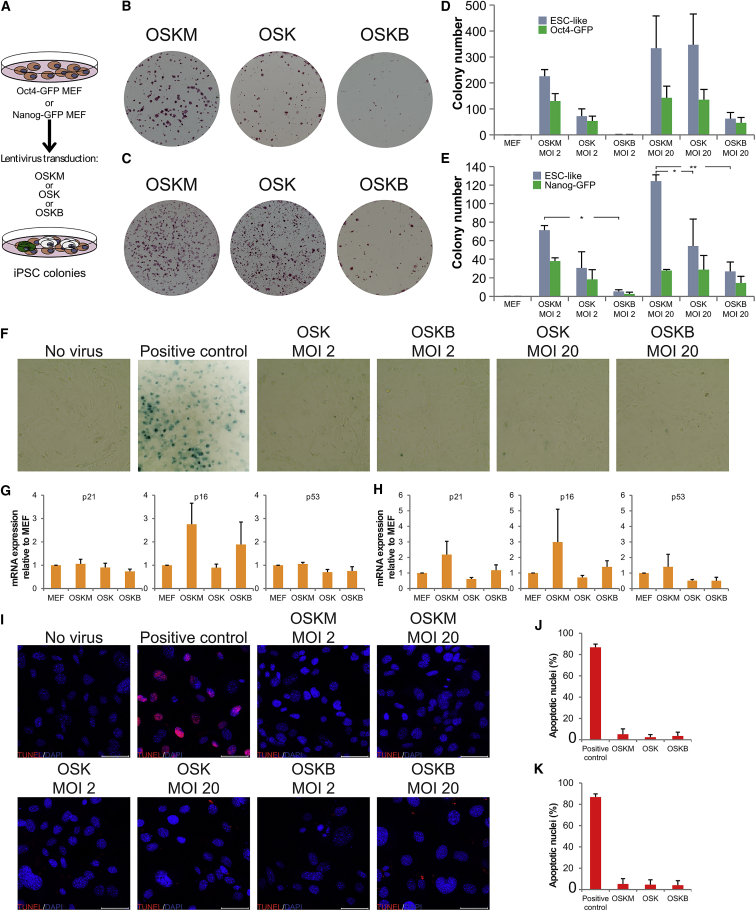
Mybl2 Overexpression Inhibits Somatic Reprogramming(A) Schematic representation of the experimental procedure. Oct4-GFP or Nanog-GFP MEFs were transduced with MOI 2 or MOI 20 OSKM, OSK, or OSKB lentiviral particles and allowed to reprogram for 14 days before GFP+ colonies were counted. The cells were stained for alkaline phosphatase activity.(B and C) Alkaline phosphatase staining (red) of Oct4-GFP MEFs at day 14 after transduction with MOI 2 (B) or MOI 20 (C).(D) Bar graph representing the number of ESC-like colonies based on morphology and the number of Oct4-GFP-expressing colonies. Error bars represent SEMs. n = 3 biological replicates.(E) Bar graph representing the number of ESC-like colonies based on morphology and the number of Nanog-GFP-expressing colonies. Error bars represent SEMs. n = 3 biological replicates. ∗p < 0.05, ∗∗p < 0.01.(F) Oct4-GFP MEFs were transduced with OSKB or OSK lentiviral particles at MOI 2 or MOI 20. After 3 days the cells were fixed and stained for β-galactosidase activity, a marker of senescent cells. Representative image from 20× magnification inverted bright-field microscope. For positive control, MEFs were cultured at 100% confluence for 10 days without passage. n = 2 biological replicates.(G and H) Wild-type MEFs at day 3 during reprogramming using OSKM, OSK or OSKB at MOI 2 (G) or MOI 20 (H). RNA expression of p21 (left), p16 (middle), and p53 (right) was measured by qRT-PCR, normalized against the β2-microglobulin housekeeping gene, and expressed relative to non-transduced MEFs. n = 3 biological replicates.(I) Wild-type MEFs were transduced with OSKM, OSK, or OSKB at MOI 2 or MOI 20. After 3 days, MEFs were stained for genomic DNA fragmentation with the TUNEL assay. Representative merged images at 40× magnification from confocal microscope show apoptotic nuclei (red) and DAPI (blue). Scale bar represents 50 μm. Positive control, MEFs treated with DNase I; negative control, non-transduced MEFs.(J and K). Quantification of apoptotic nuclei counts from each condition MOI 2 (J) and MOI 20 (K). n = 2 biological replicates.See also Figure S2.